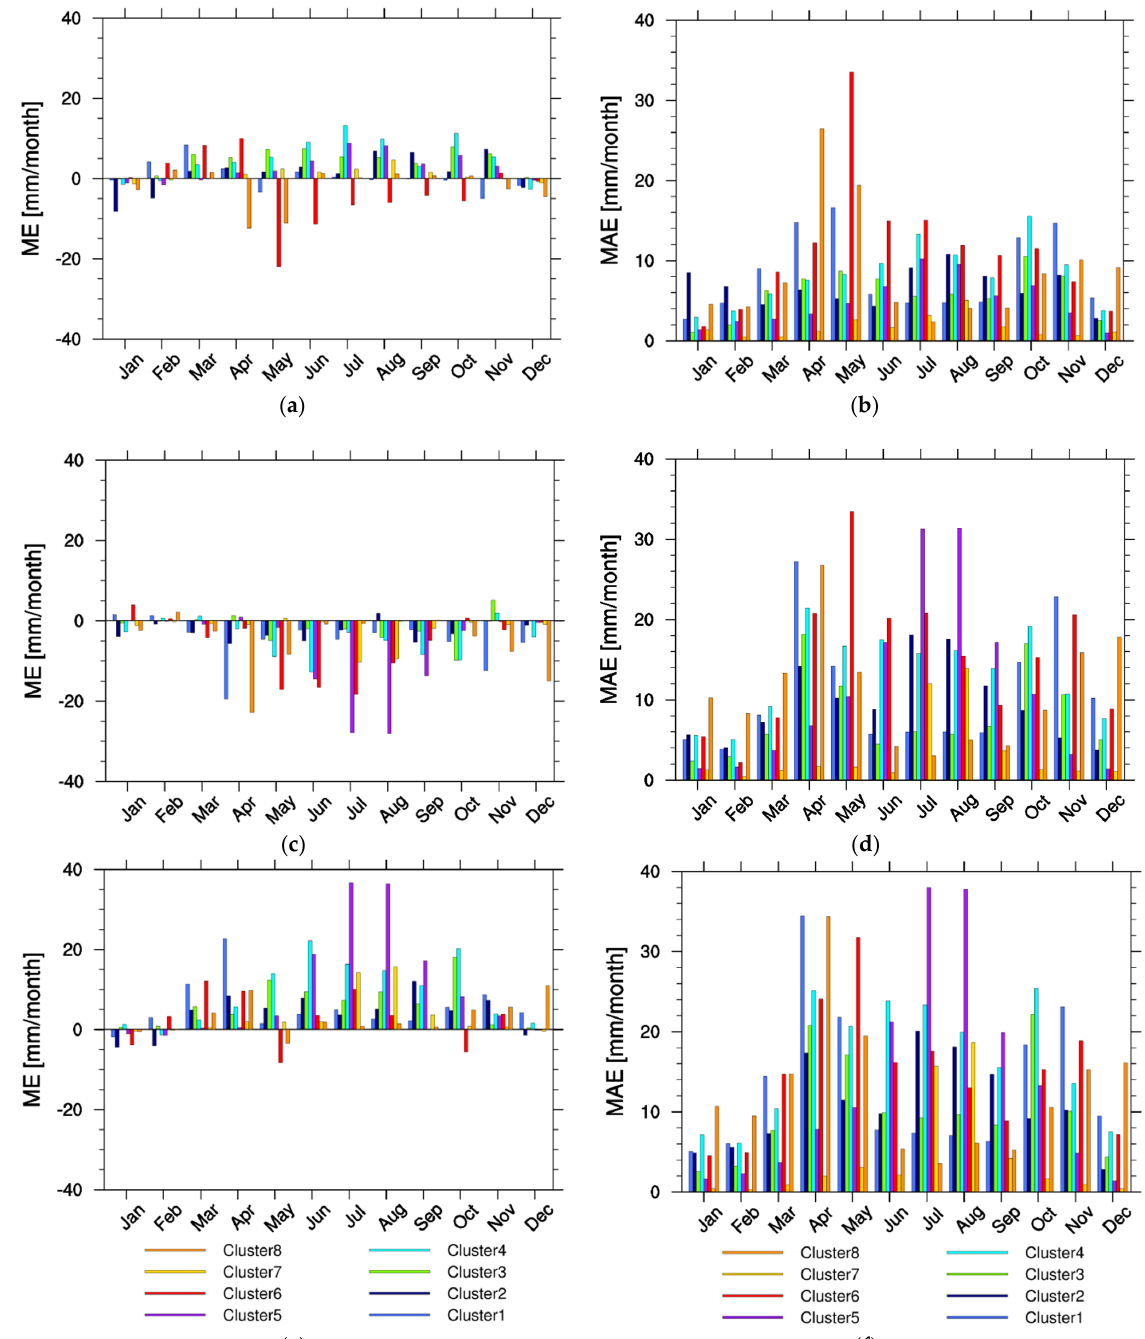
Figure 7. EA cluster–average monthly ME and MAE values from TAMSAT3 with respect to CHIRPS ( a , b ), MSWEP with respect to CHIRPS ( c , d ), and TAMSAT3 with respect to MSWEP ( e , f ).